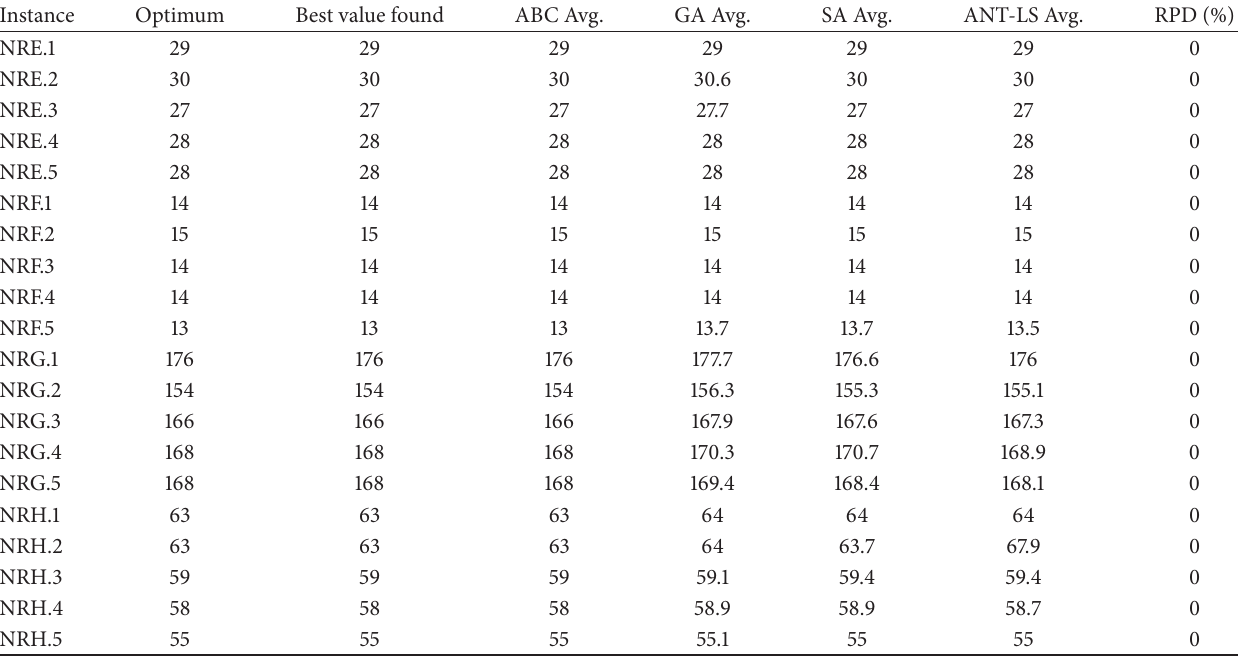
Table 5: Experimental results—instances with best known